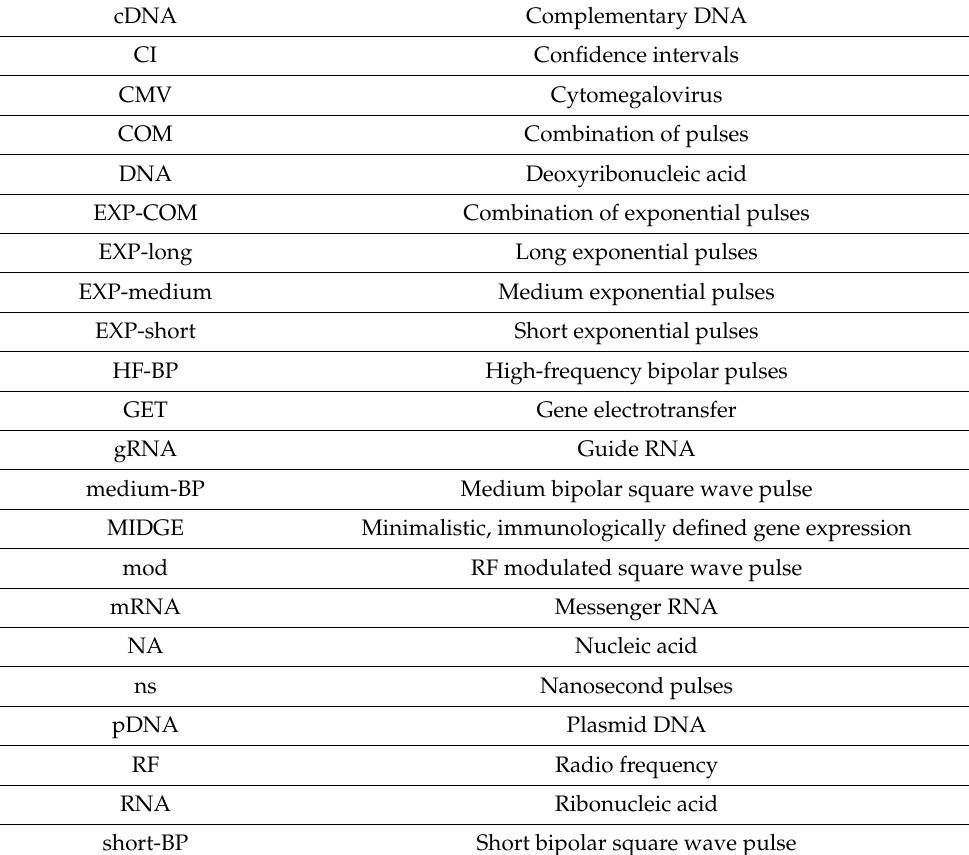
Table 1. Summary of all abbreviations used throughout the